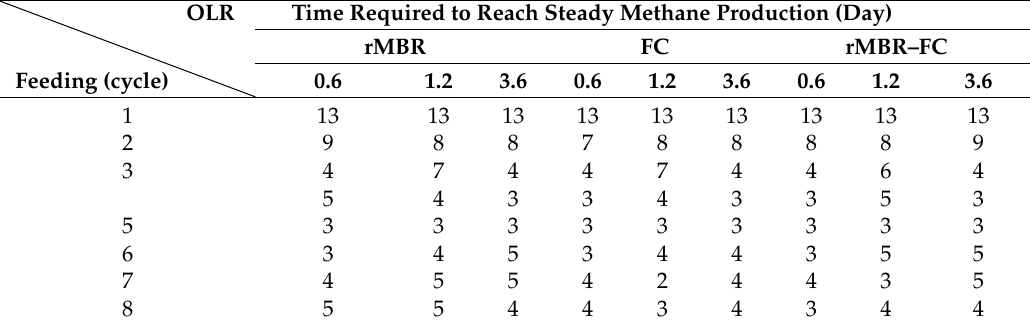
Table 2. Required time for each configuration to reach steady (plateau) accumulated methane production. OLR Time Required to Reach Steady Methane Production (Day) rMBR FC rMBR–FC Feeding (cycle)